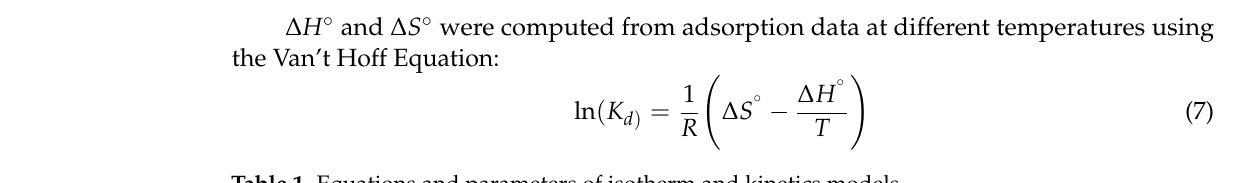
Table 1. Equations and parameters of isotherm and kinetics models.